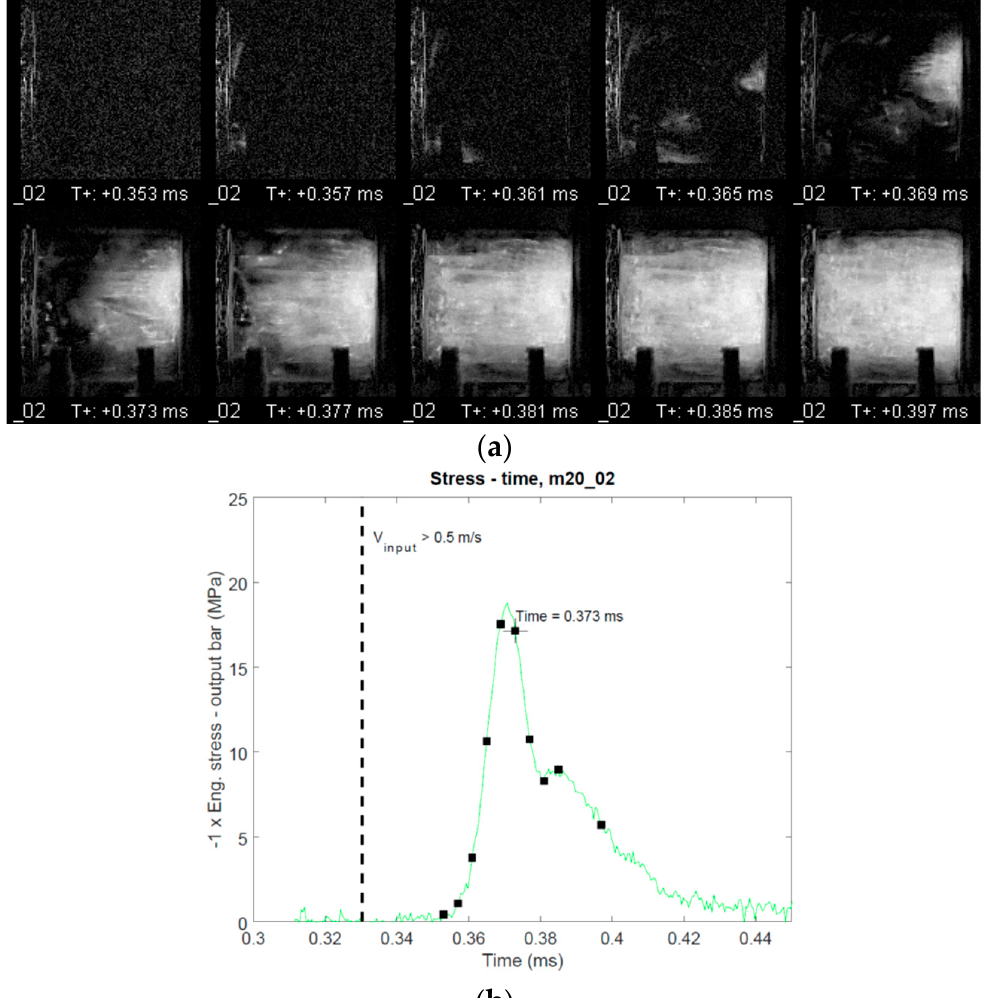
Figure A1. ( a ) processed high speed footage obtained in the high rate test m20_02, ( b ) corresponding specimen stress-time signal obtained from the output bar strain gauge measurement (synchronized with high speed footage). The input bar is located on the left-hand side of the figure in ( a ). The time, at which the input bar end velocity exceeded 0.5 m / s as well as the times corresponding to the high speed frames are marked on the respective stress-time curve.